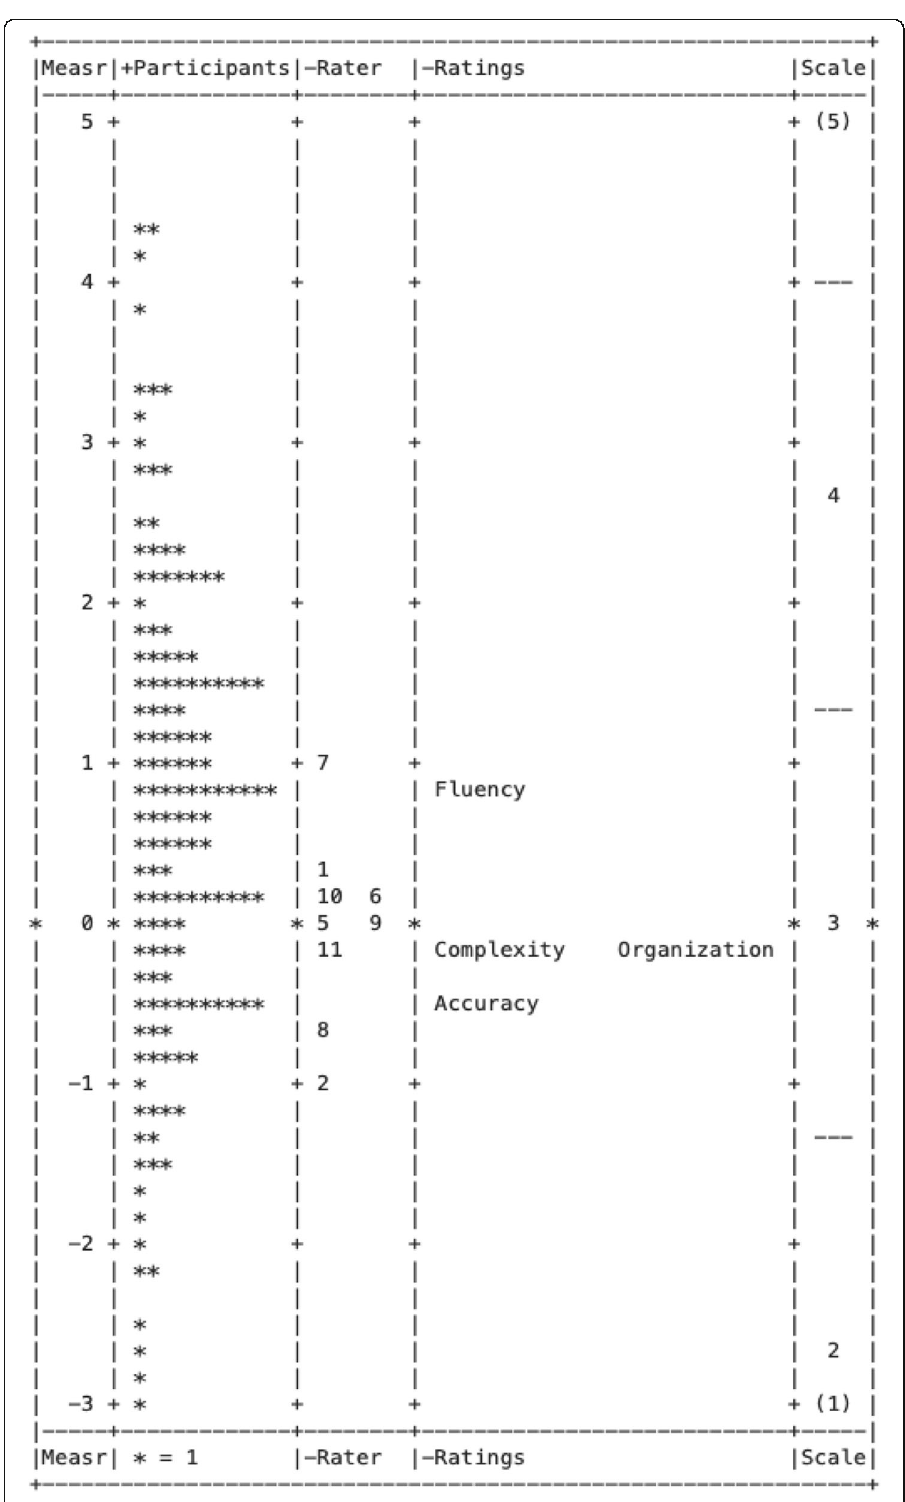
Fig. 1 FACET summary for the monologue